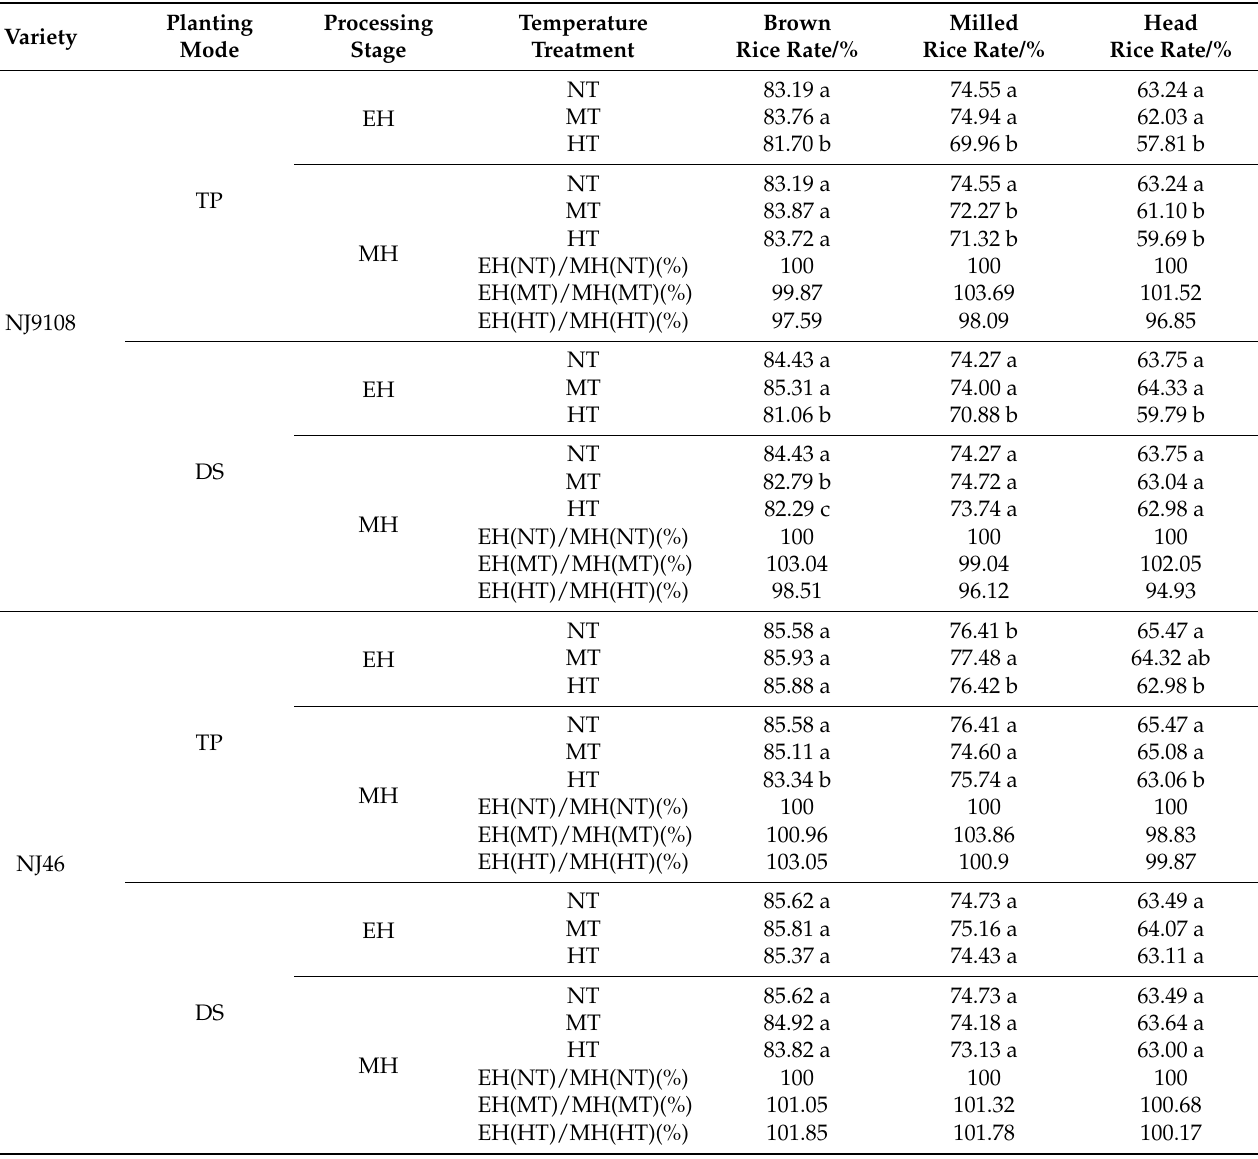
Table 3. Effects of high temperature on processing quality of japonica rice in early and middle heading stage under transplanting and direct